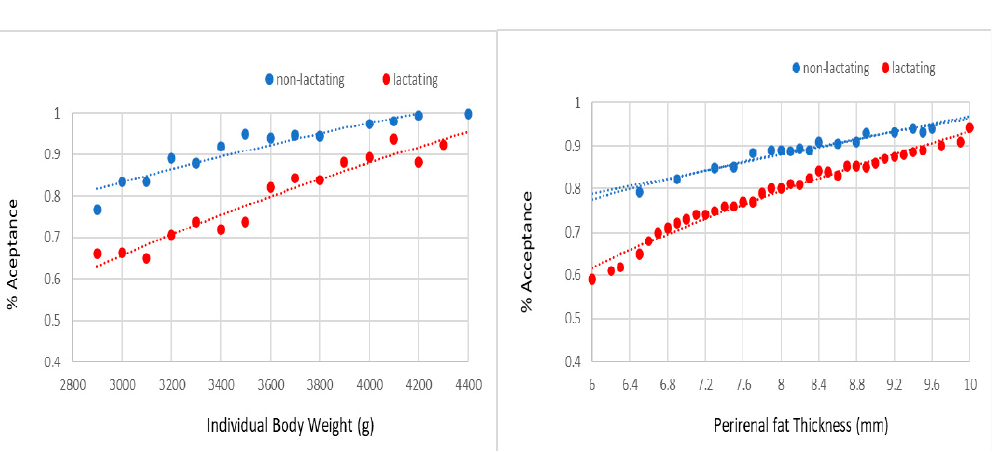
Table 2. Features of the marginal posterior distribution of the di ff erences for individual body weight (IBW10d) and perirenal fat thickness (PFT10d) at 10 days after delivery for receptivity and fertility. Receptive Non-Receptive D HPD 95%